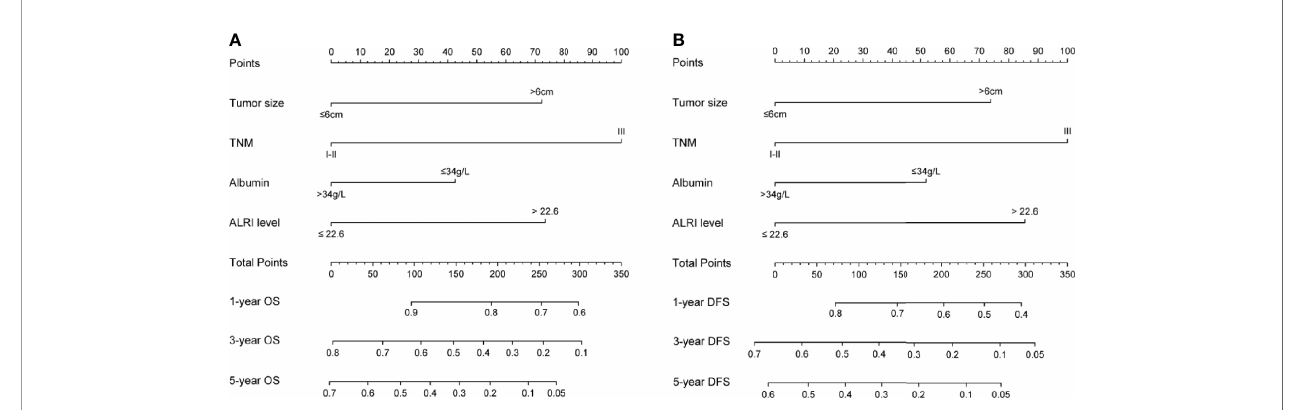
FIGURE 3 | Nomograms for OS and DFS in the training cohort. Sum up the score of each factor, and 1-, 3-, and 5-year OS were determined according to the total score. The 1-, 3-, and 5-year DFS were determined in the same way (A, B)